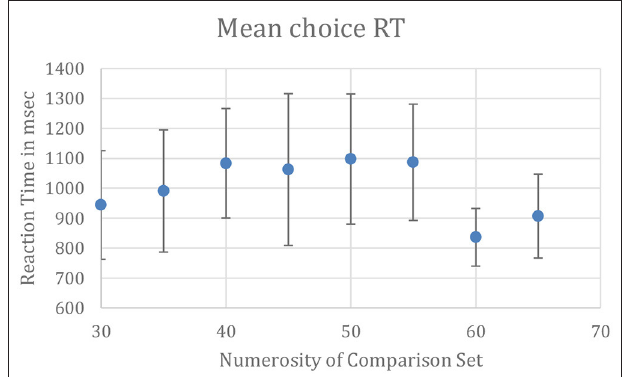
FIGURE 2 | Latencies for reporting which set of intermingled disks, white or gray, were more numerous. Mean RTs were in the range of 0.8–1.2s, typical for estimation and far faster than counting. The standard set contained 50 disks. Bars show ± 1 SE calculated between subjects; confidence intervals are 28% larger than the